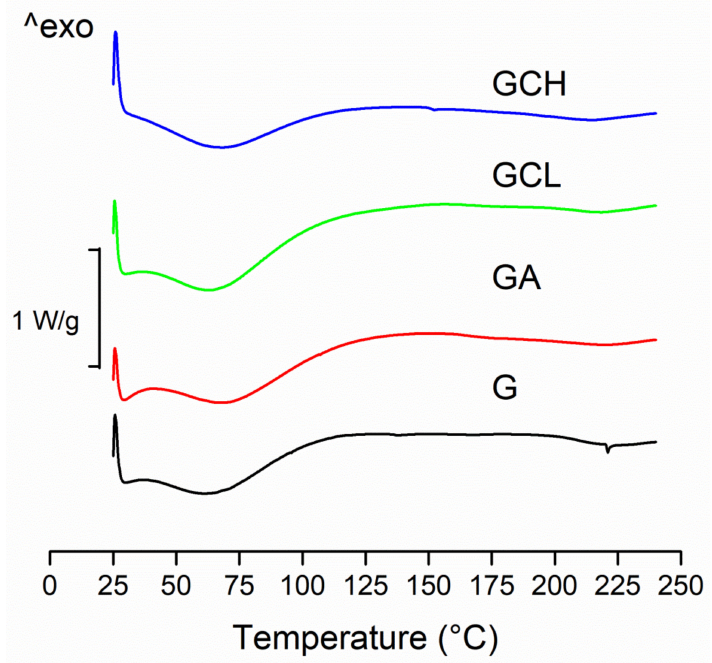
Figure 4. Differential scanning calorimetry DSC thermograms of scaffolds: G, GCL, GCH and